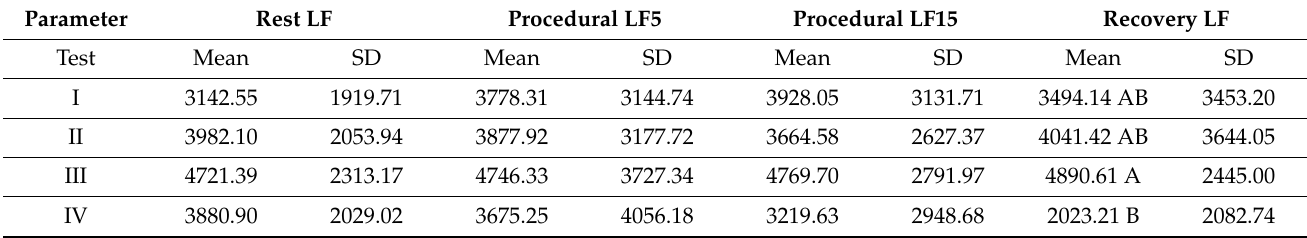
Table 7. LF (low-frequency spectrum power) during consecutive tests.